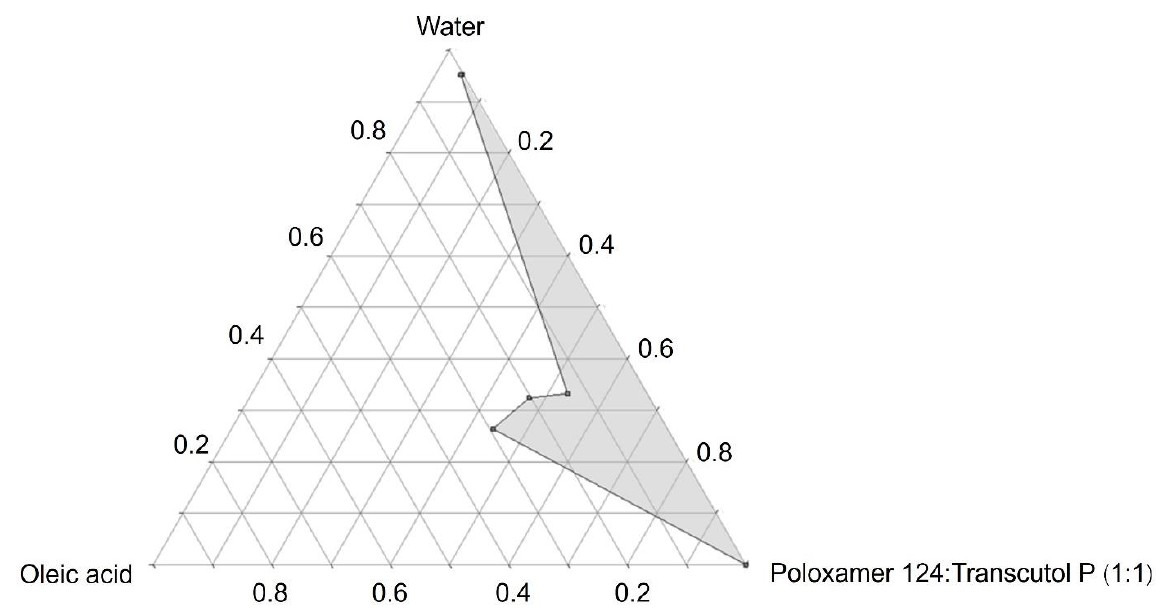
Figure 1. Pseudoternary phase diagram composed of oleic acid as the oil phase, poloxamer 124 as the surfactant, Transcutol P as the cosurfactant, and water as the aqueous phase. The surfac- tant:cosurfactant ratio = 1:1 w / w . The gray area represents the microemulsion region. Table 2. Formulations, component ratios, and concentrations of finasteride loaded in microemulsions.